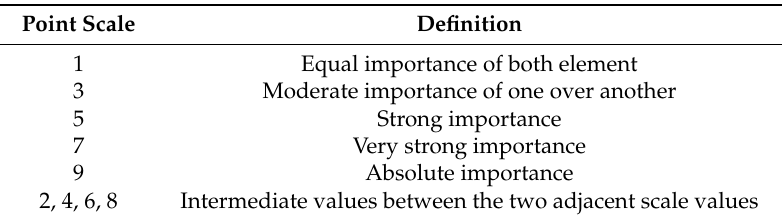
Table 5. Saaty’s 1–9 point scale.